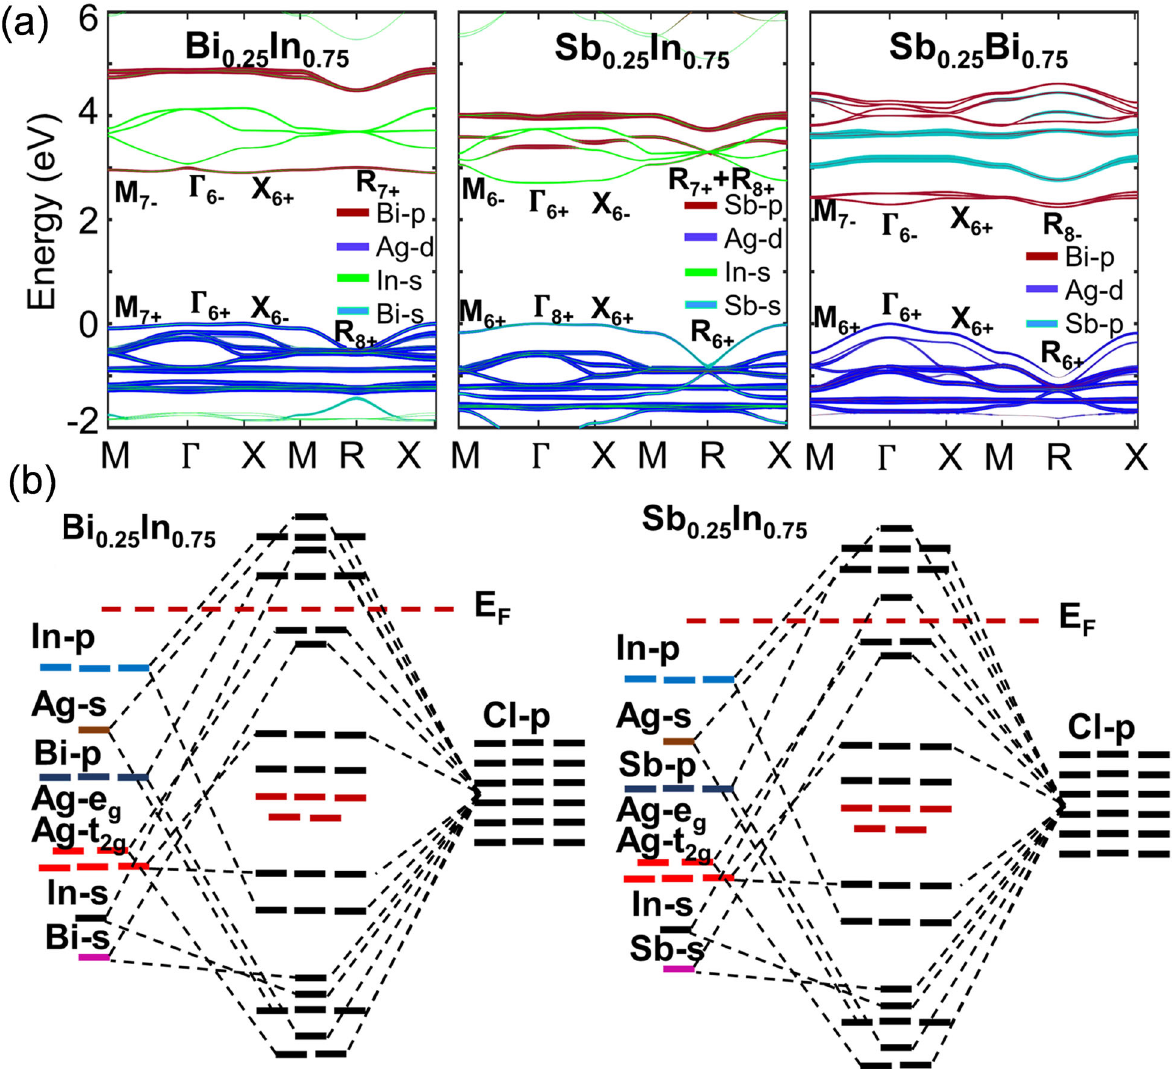
Fig. 6 Band structure of mixed trivalent halide double perovskites. a Band structure of mixed Cs 2 AgBi 0.25 In 0.75 Cl 6 , Cs 2 AgSb 0.25 In 0.75 Cl 6 , and Cs 2 AgSb 0.25 Bi 0.75 Cl 6 double perovskites with dominant orbital characters and parities of eigenfunctions in terms of Koster notations at valence and conduction band edges. b Molecular orbital picture of mixed Cs 2 AgBi 1 − x In x Cl 6 and Cs 2 AgSb 1 − x In x Cl 6 double perovskites obtained from the analysis of orbital resolved bands and density of